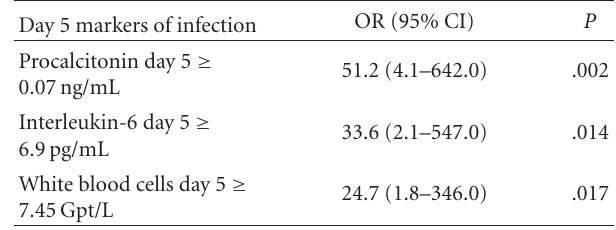
Table 3: Independent day 1 predictors of infection and severe infection.